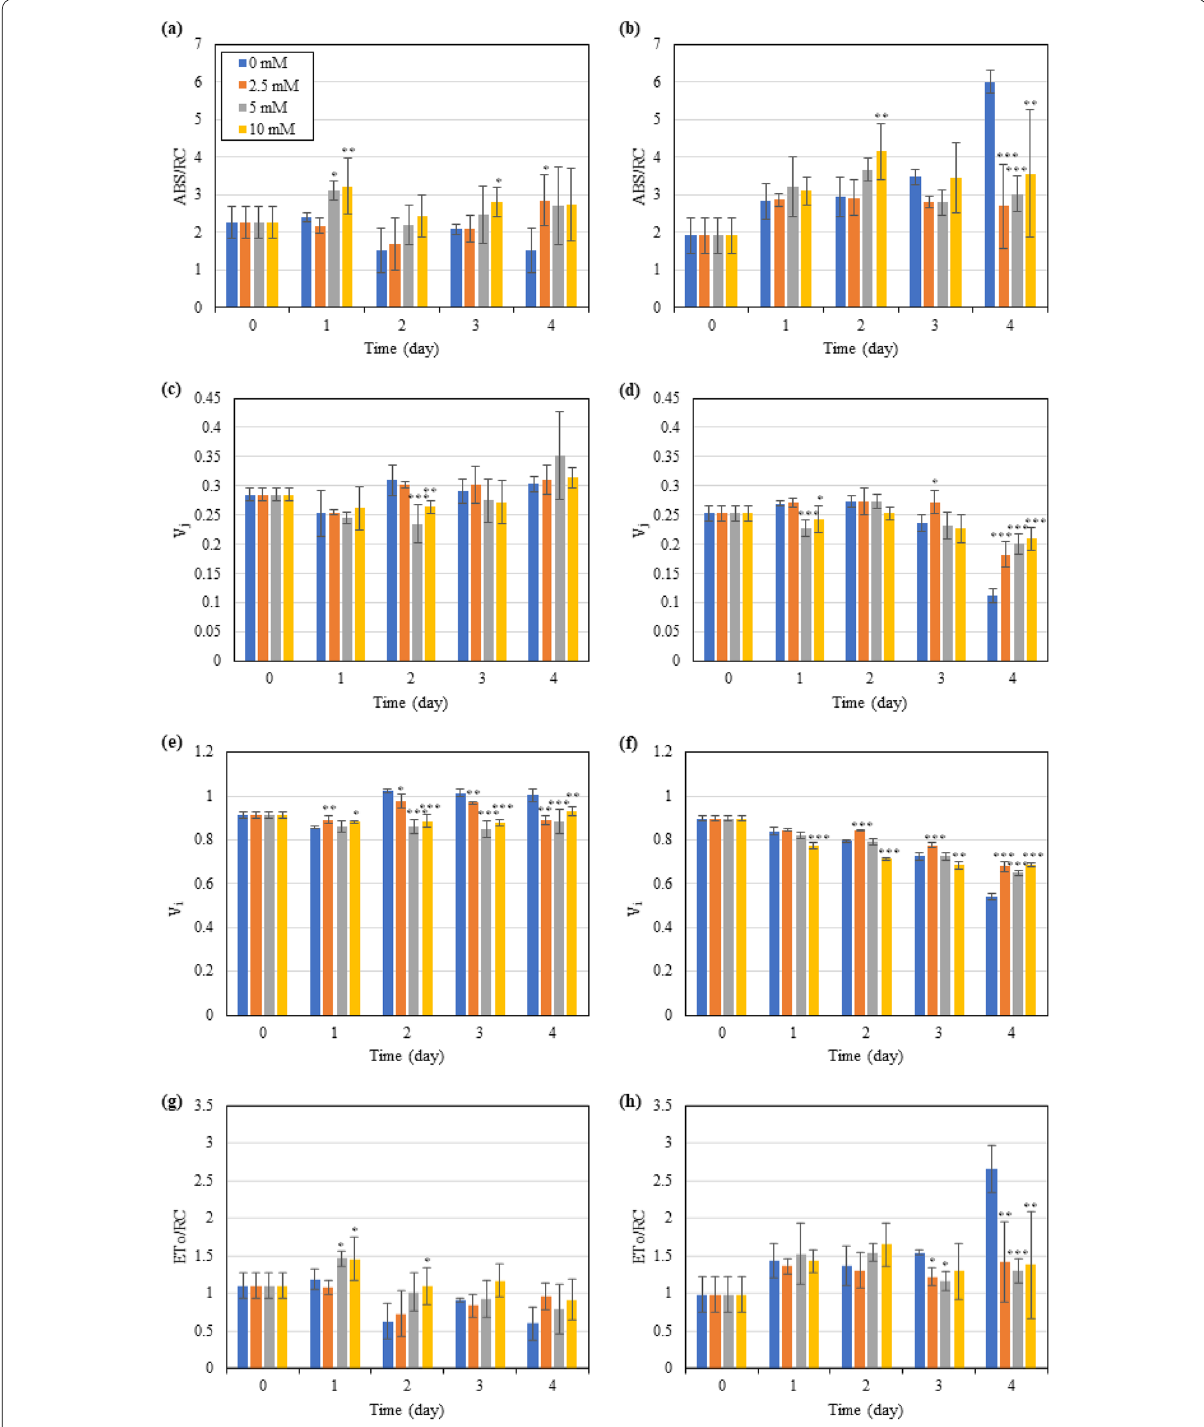
Fig. 3 Effect of exogenous GABA supply on the specific energy fluxes per fully active PSII reaction centre (ABS/RC, a , b ), relative variable fluorescence at the J -step ( V j , c , d ) and I -step ( V i , e , f ), and electron transport flux per RC (ET 0 /RC, g , h ) in T. subcordiformis exposed to nitrogen deprivation under NICD ( a , c , e , and g ) and HICD ( b , d , f , and h ). *, **, and *** denote the significant differences at p < 0.1, p < 0.05, and p < 0.01 levels, respectively, under different GABA conditions (2.5–10 mM) compared to those under 0 mM GABA (means